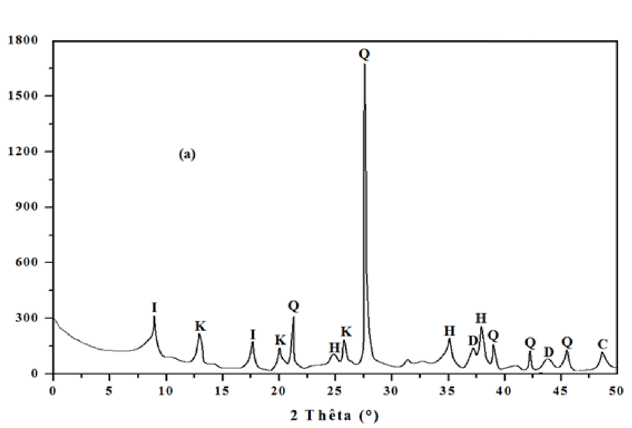
Fig. 1. XRD diffractograms of the clay RC. Table 2. Chemical constitution of the